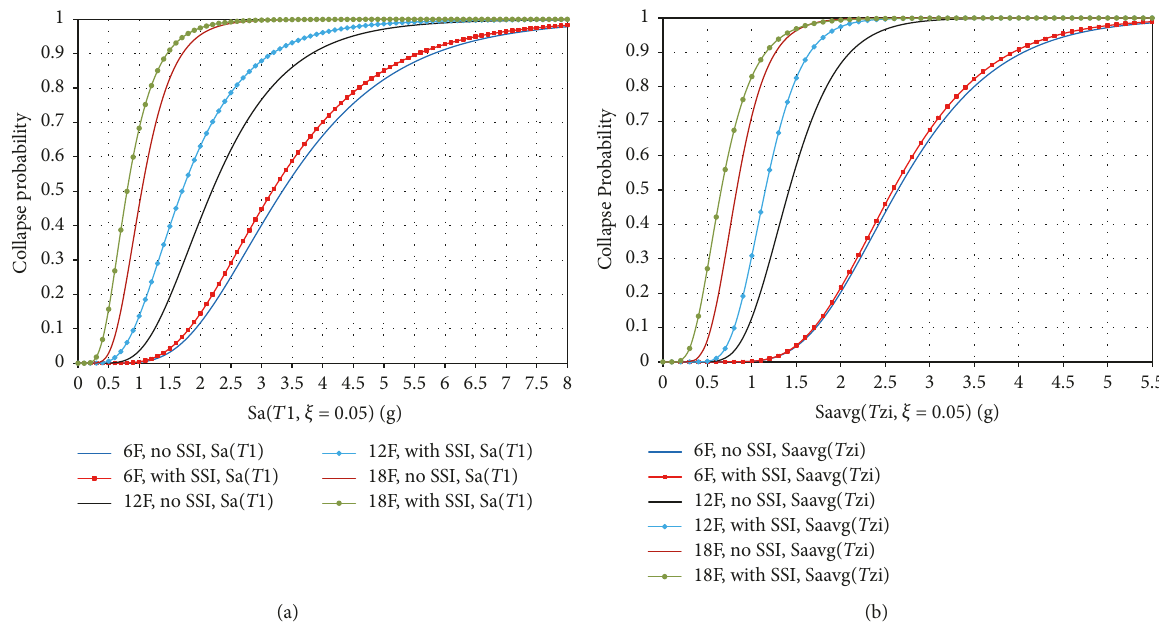
Figure 7: Fragility curves of the studied buildings in two states: fixed base and considering SSI. (a) IM = Sa (𝑇 1 , 𝜉 = 0.05) ; (b) IM = Saavg (𝑇 𝑧𝑖 ,𝜉 = 0.05) .